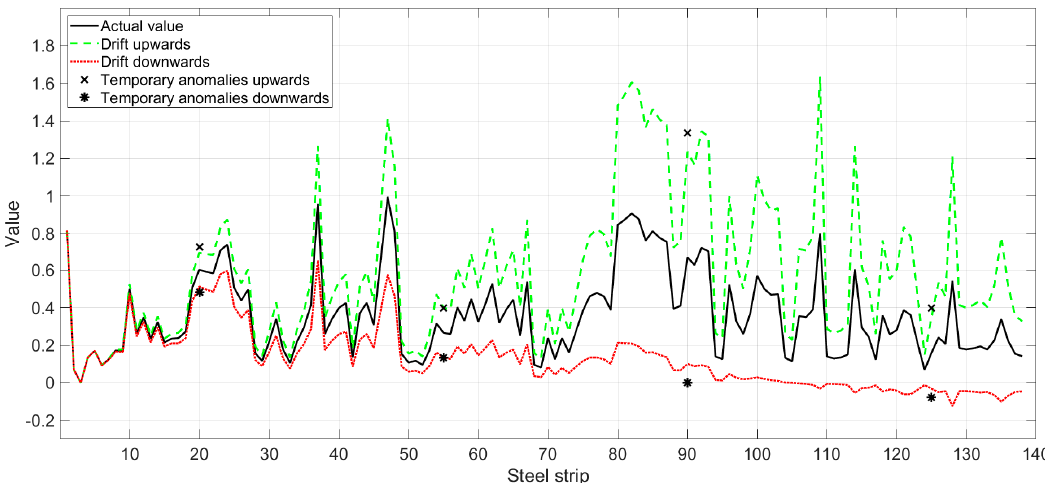
Figure 15. Di ff erent anomalies in the explanatory variable x 1 of thickness Figure 15. Different anomalies in the explanatory variable x 1 of thickness model.